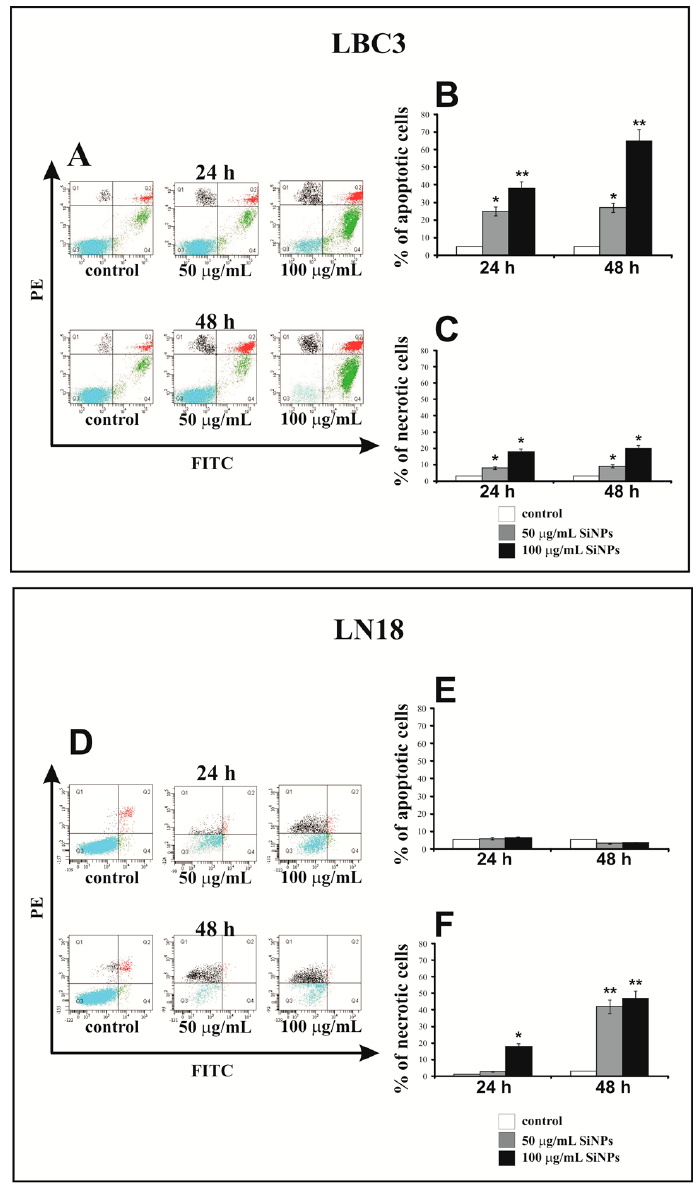
Figure 3. The effect of SiNPs on apoptosis ( A , B , D , E ) and necrosis ( A , C , D , F ) of LBC3 ( A – C ) and LN-18 ( D – F ) cell lines evaluated by annexin V assay. The cells were incubated for 24 and 48 h in DMEM with 50 and 100 µ g/mL of 5–15 nm SiNPs. The cells were double-stained with FITC-Annexin V and PI. Representative dot plots for Annexin V-FITC/propidium iodide (PI) staining are shown ( A , D ). Following acquisition of sample, the cells were gated through the forward scatter FSC and side scatter SSC and analyzed for fluorescence intensity of FITC-Annexin V and PI. The cells were divided into four subpopulations: live cells—Q3 (annexin V-FITC − /PI − ), early apoptotic cells—Q4 (annexin V FITC+/PI − ), late apoptotic cells—Q2 (annexin V-FITC+/PI+), and necrotic cells—Q1 (annexin V FITC − /PI+). Percentage of apoptotic cells was the sum of percentage early apoptotic (Q4) and late apoptotic cells (Q2). Mean values of the percentage of apoptotic and necrotic cells, from three independent experiments ± SD are presented. Significant alterations are expressed relative to controls and marked with asterisks. Statistical significance was considered if * p < 0.05 or ** p <